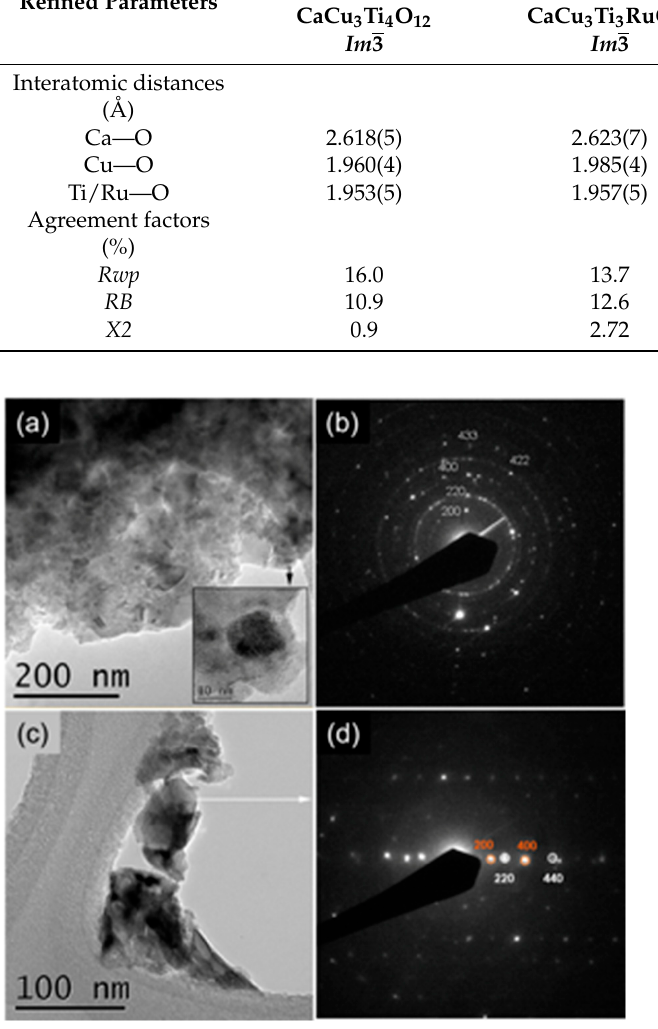
Refined Parameters